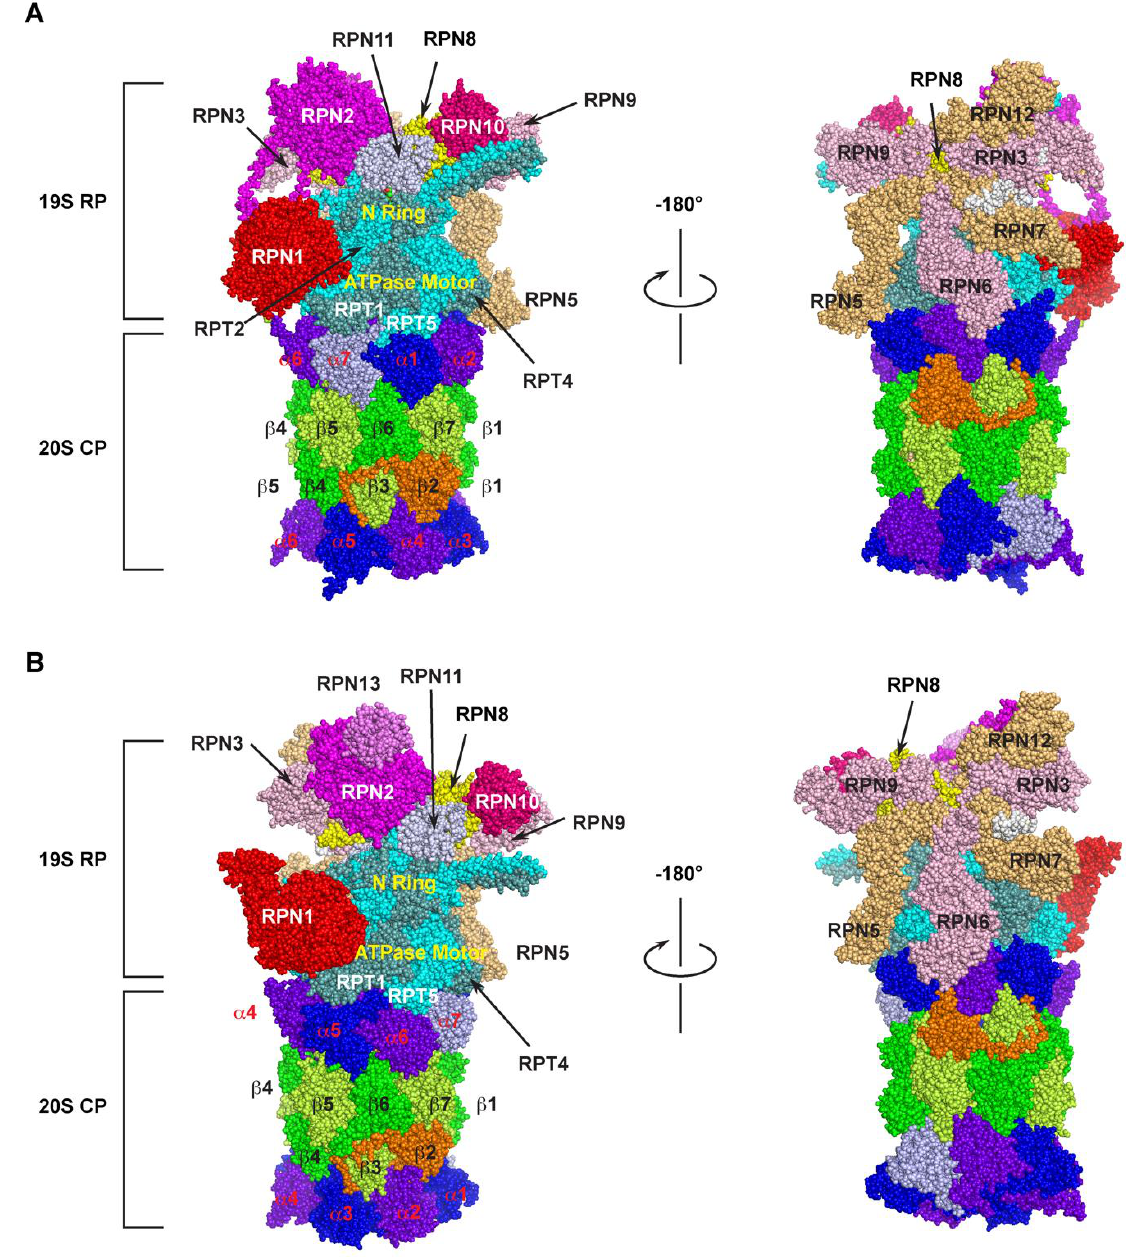
Figure 1. Cryo-electron microscopy (Cryo-EM) structure of the 26S proteasome. The spherical structure is generated based on PDB 6MSK [36] and 3JCP [37] for humans ( A ) and yeast ( B ) 26S proteasome, respectively. Two mirror images were shown for the detailed organization of base and lid subunits of the 19S RP subcomplex in each proteasome. The parts of N-ring and ATPase motor ring of RPT hexameric complex are indicated. The subunits of α -ring and β -ring of the 20S CP are highlighted with different colors. The human 26S proteasome structure does not include